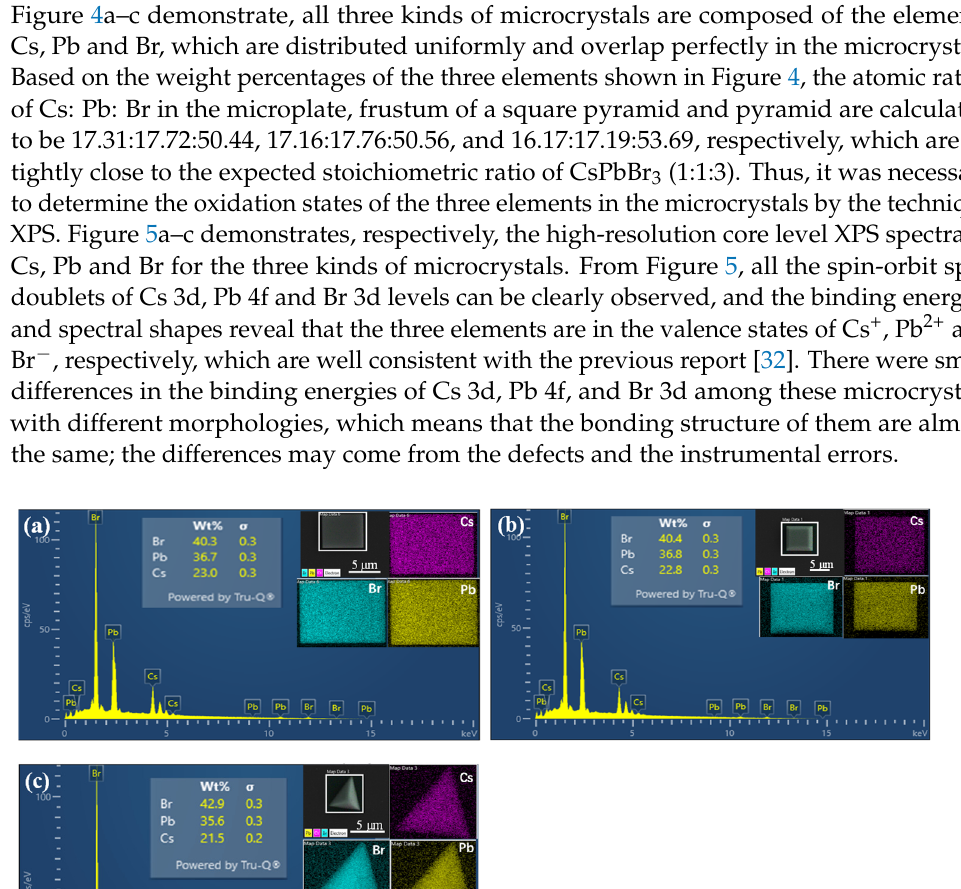
Figure 5. The XPS spectra of CsPbBr 3 microplate, frustum of a square pyramid, and pyramid for Cs 3d ( a ), Pb 4f ( b ), and Br 3d ( c ).